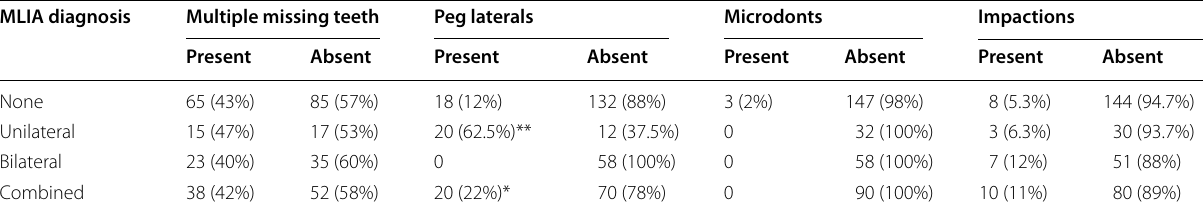
Table 3 Association of MLIA with other dental anomalies